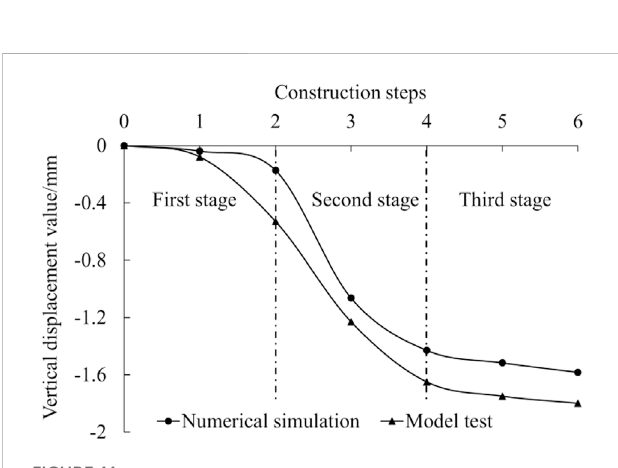
FIGURE 11 The maximum vertical displacement of existing side wall structure during opening construction.